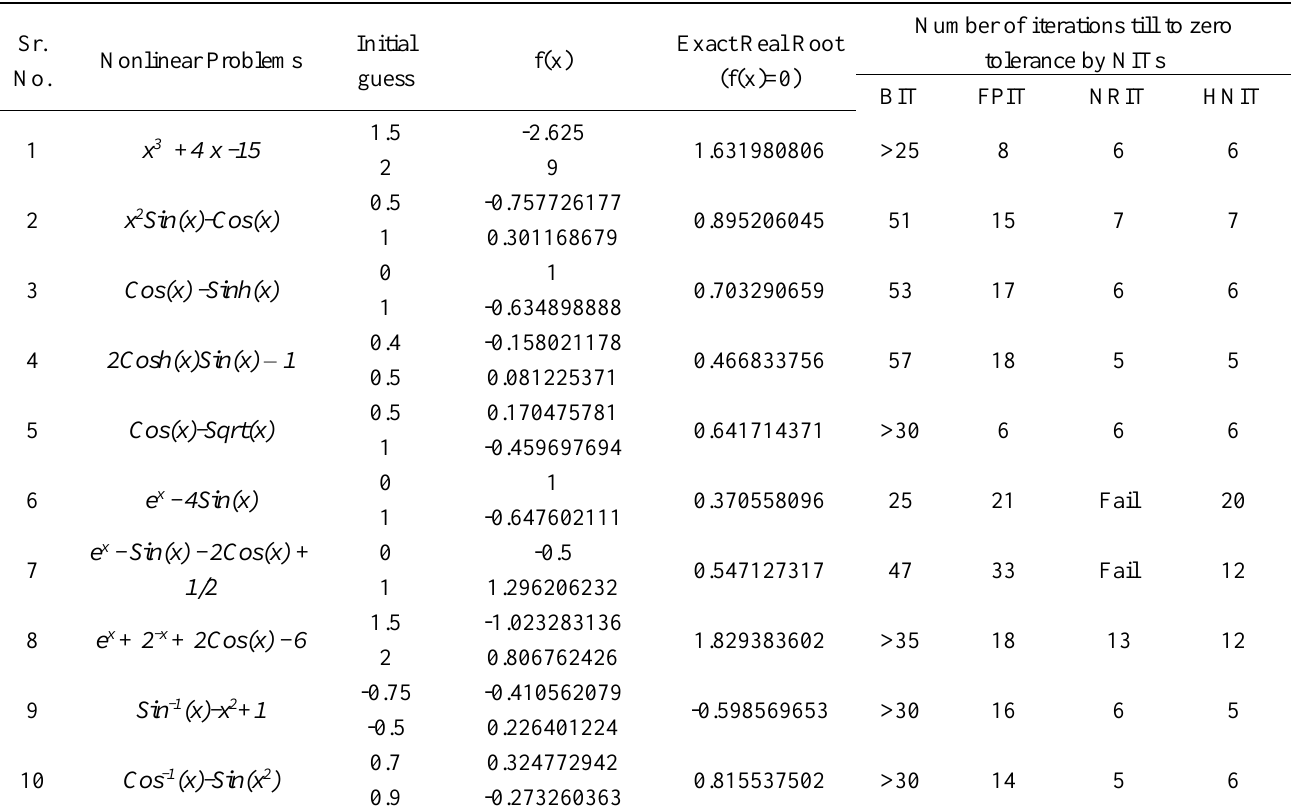
Table 5 Solution of the numerous NLPs by